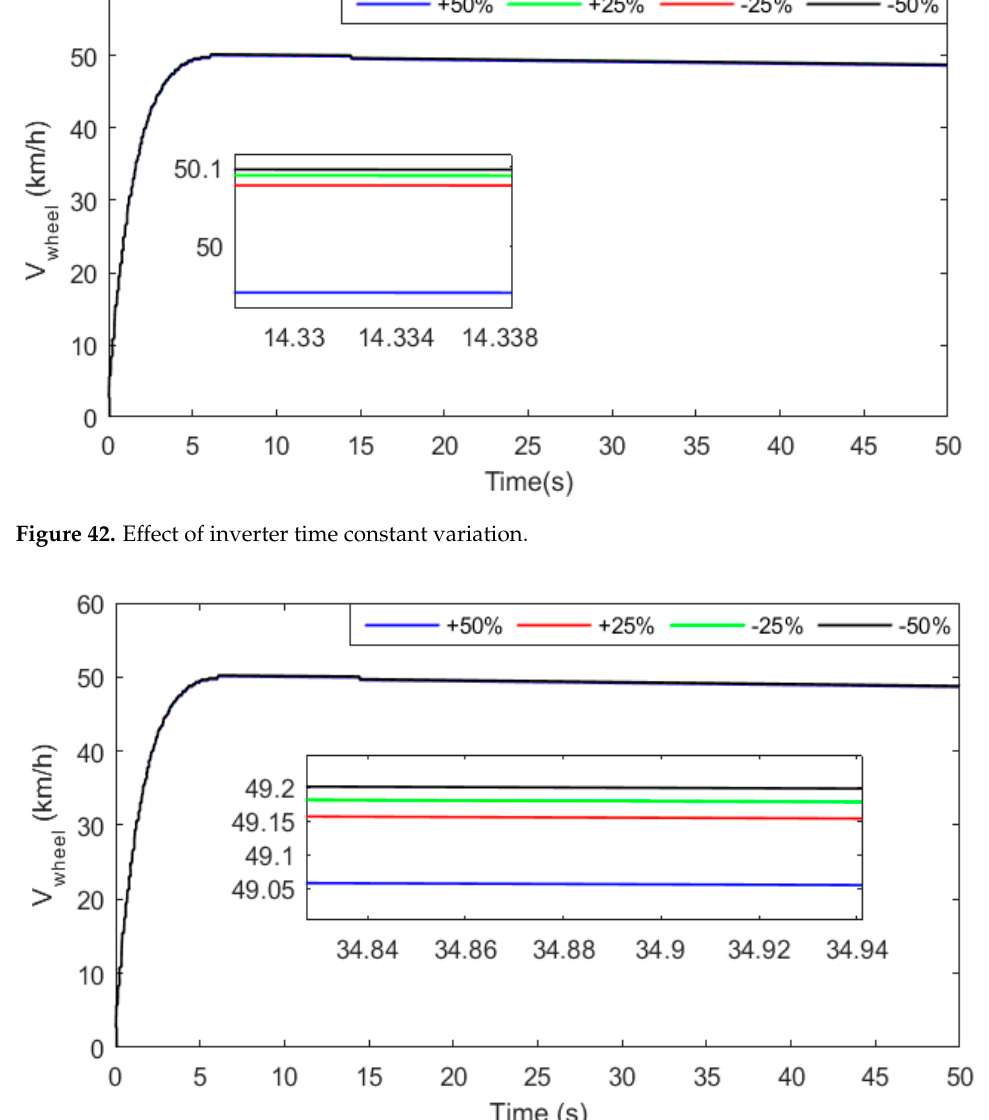
Figure 43. Effect of sensor time constant variation .